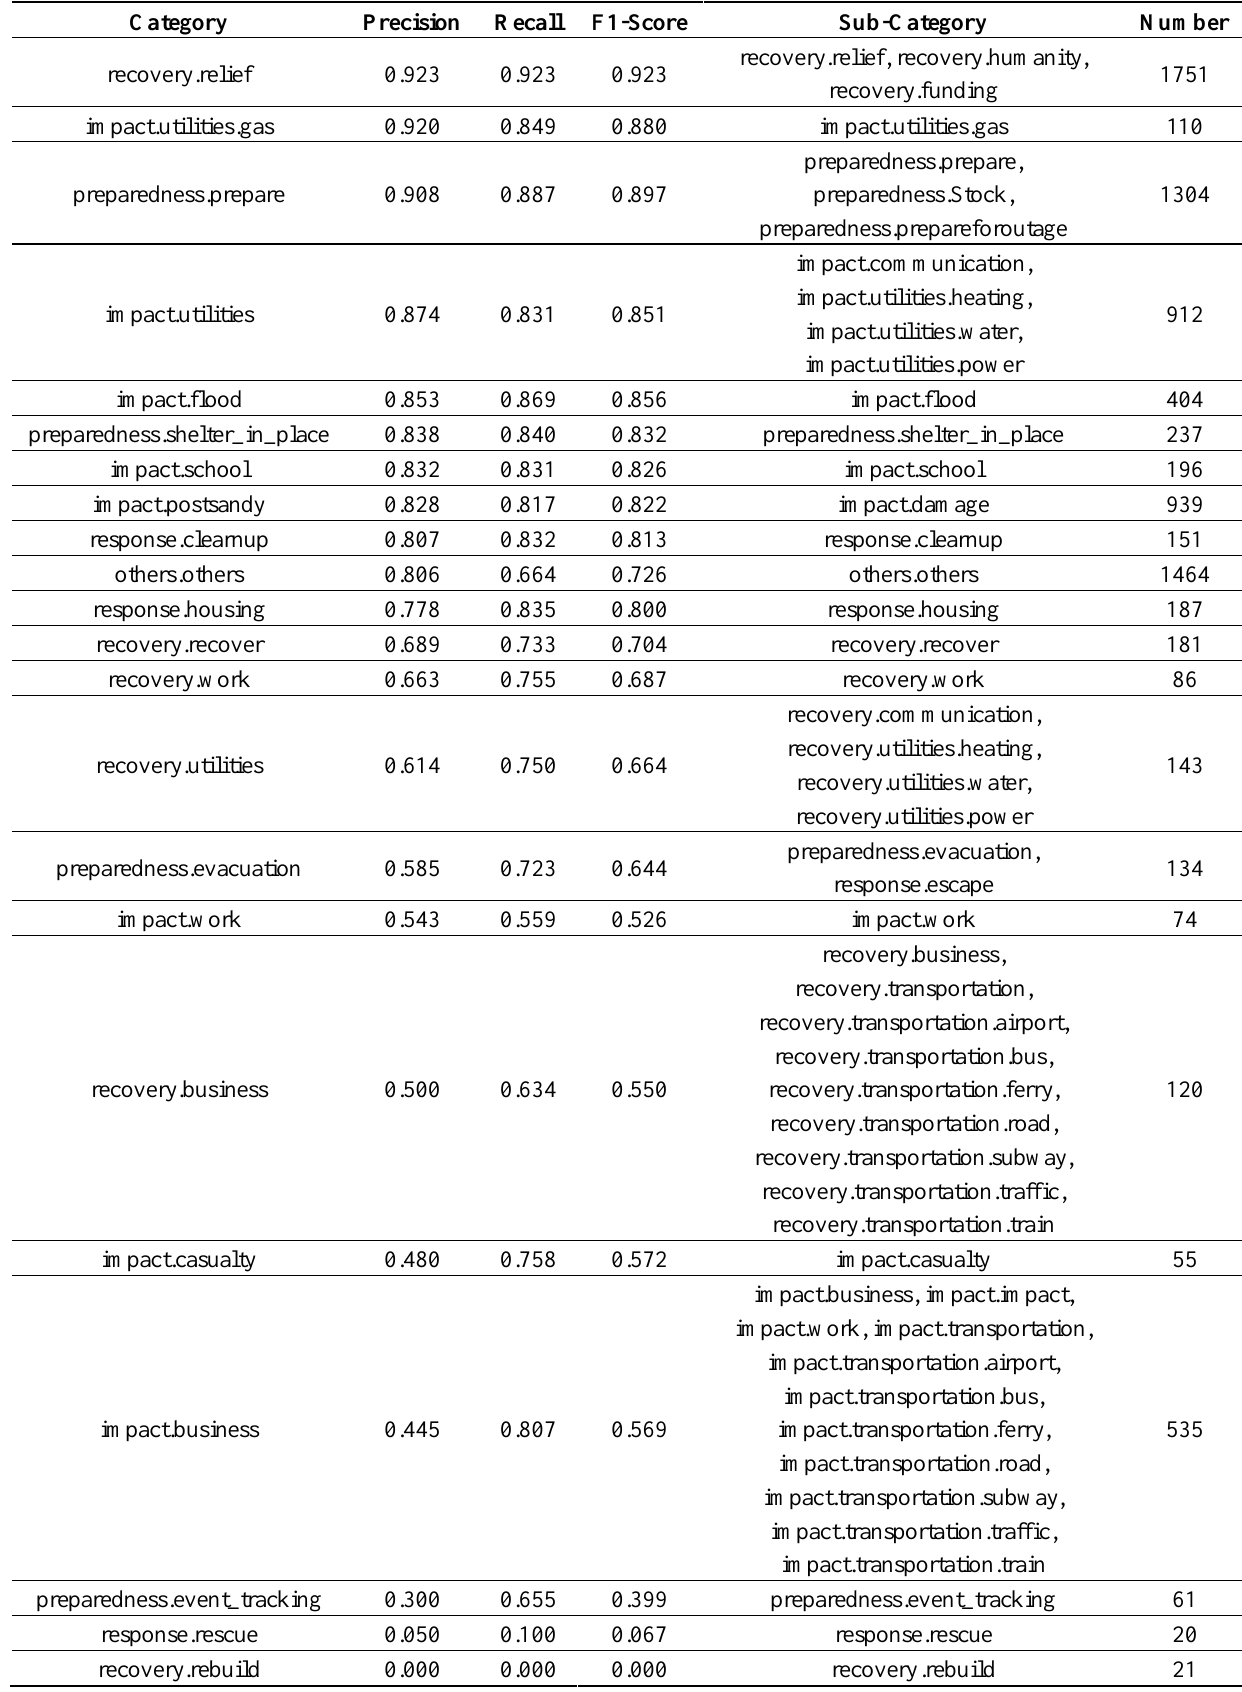
Table 2. Precision, recall, and F1-Score for the various classification tasks. Category Precision Recall